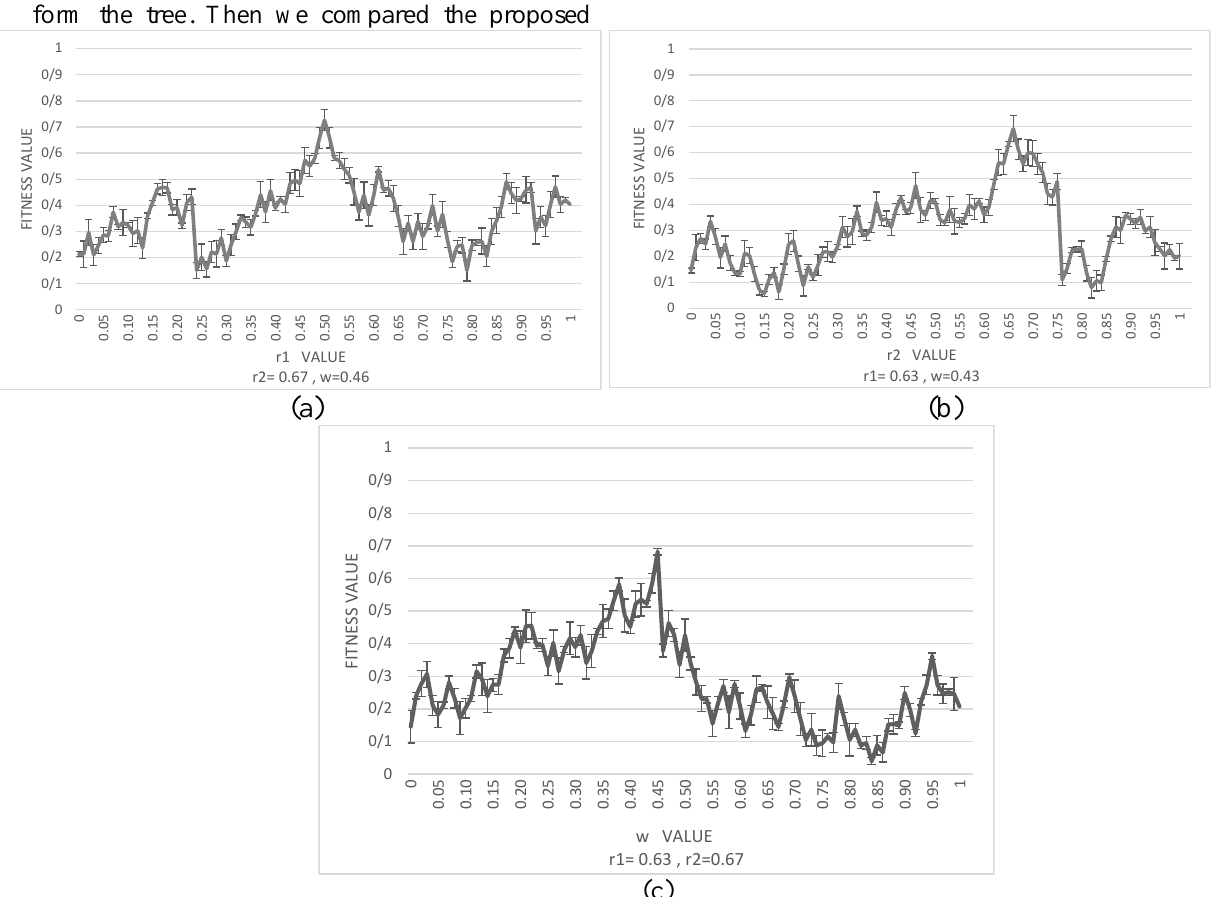
Figure 12. Effects of w , r 1 , and r 2 parameters on the values of fitness function (Average of 50 runs ± Standard